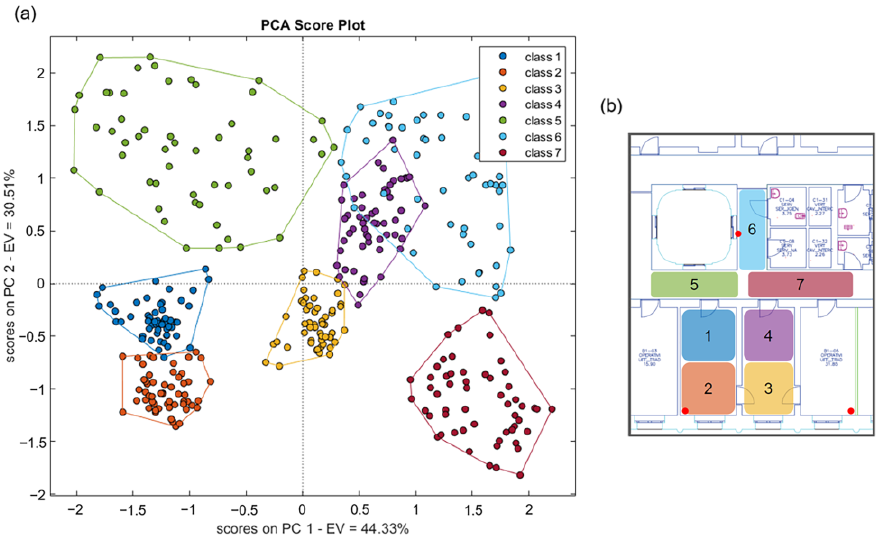
Figure 7. Scores plot of the first two principal components of the PCA model performed using the maximum value as a feature and a moving average filter of order six ( a ). The seven zones related to the seven classes are represented in ( b ).